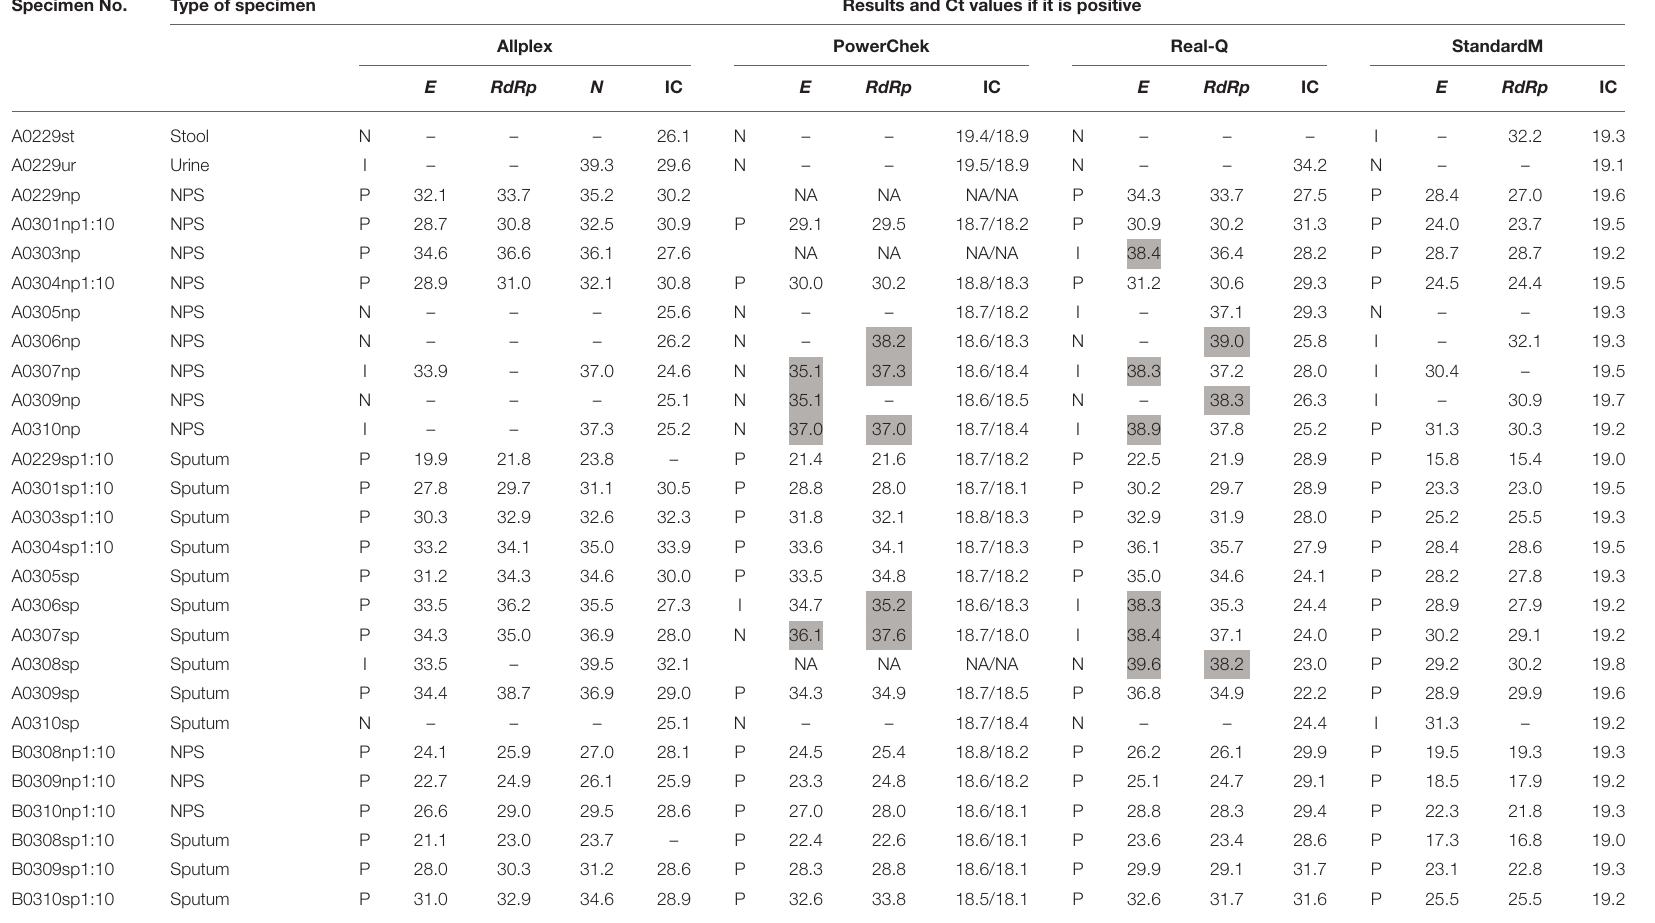
TABLE 2 | Evaluation of sensitivity of the four commercial kits with consecutive samples from two COVID-19 patients. Specimen No. Type of specimen Results and Ct values if it is